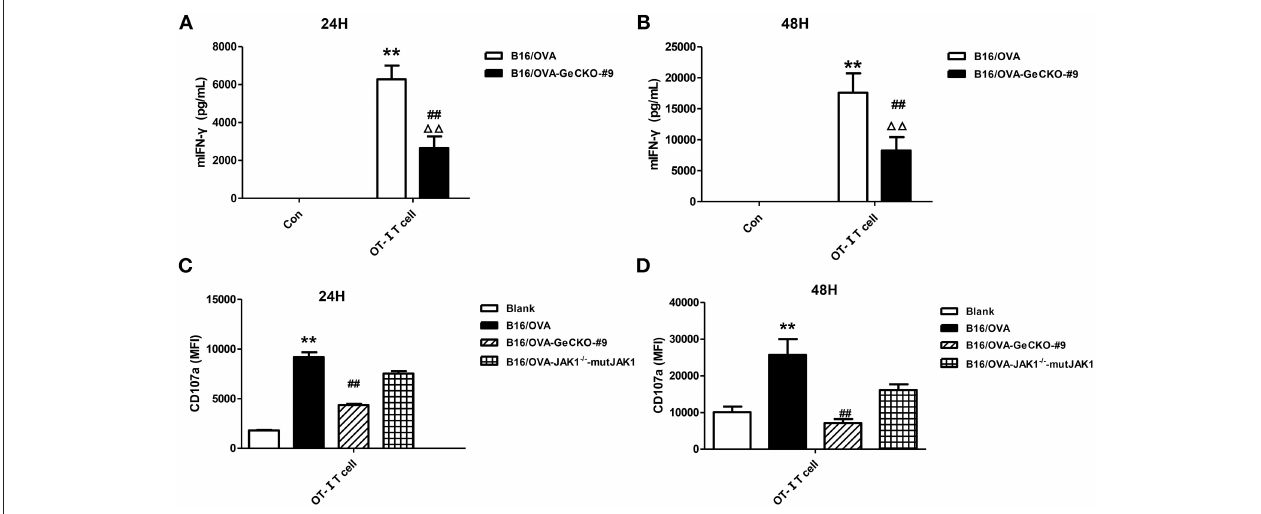
FIGURE 3 | Loss of JAK1 reduces tumor-specific T-cell activation. OT-I T-cells and indicated B16/OVA cells and their derivatives were co-cultured (E: T = 3:1) for 48h, and IFN- γ level in the supernatant (A,B) and CD107a expression in OT-I T-cells (C,D) were measured. Data are presented as mean ± SEM. ** P < 0.01 vs. B16-OVA